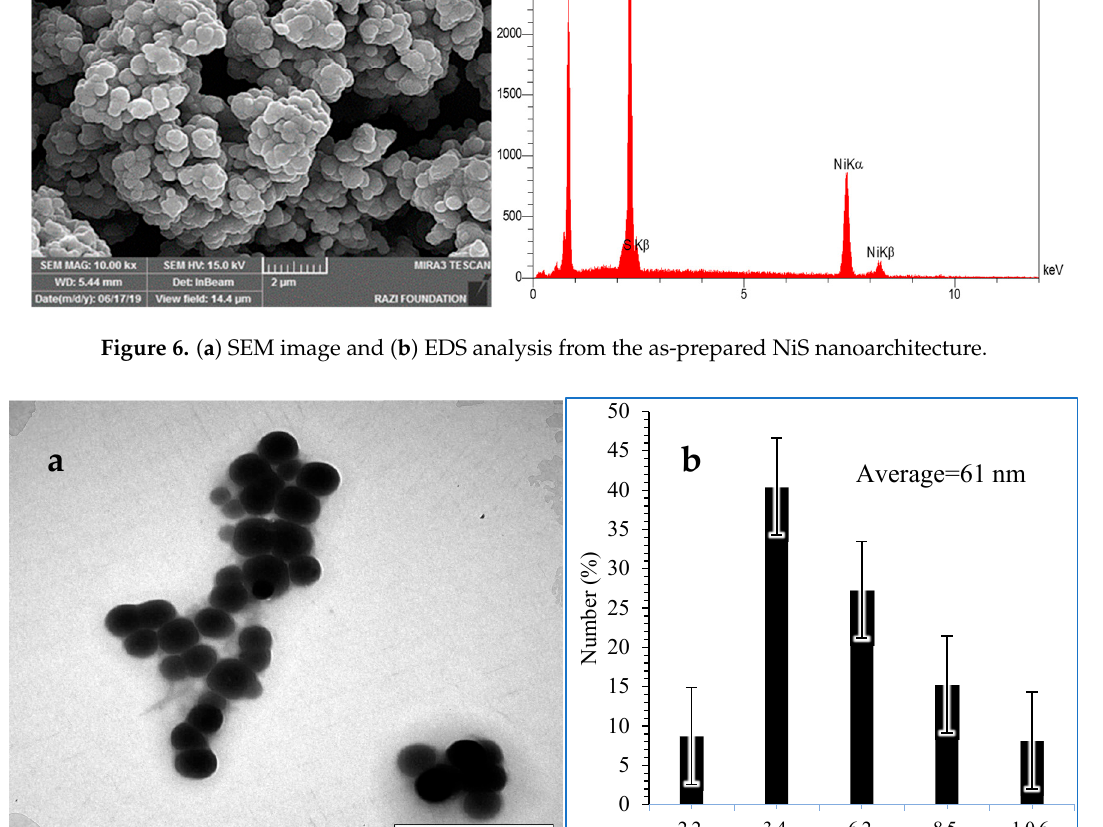
Figure 6. ( a ) SEM image and ( b ) EDS analysis from the as ‐ prepared NiS